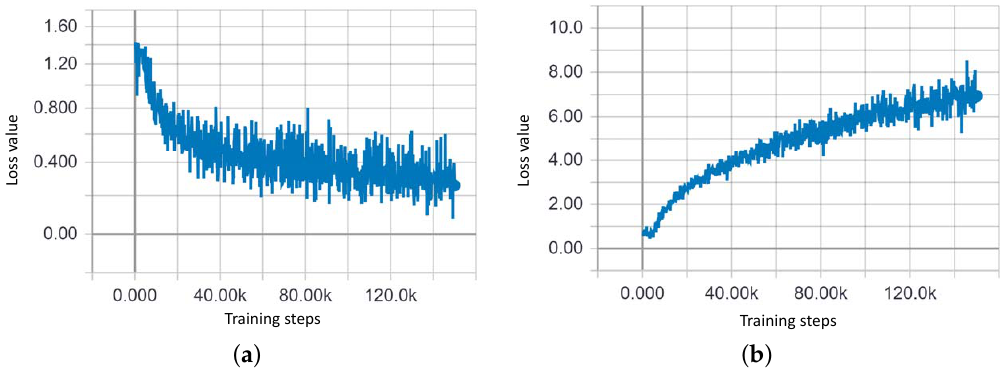
Figure 12. Losses of the DCGAN [27]. ( a ) Losses of the discriminator, and ( b ) losses of the generator.